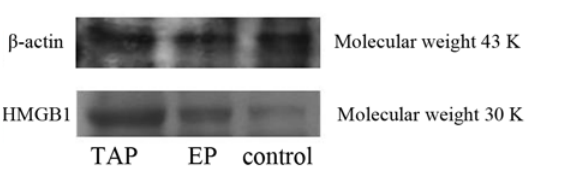
Figure 1 : HMGB1 protein expression in pancreatic acinar cells at 24 h after TAP